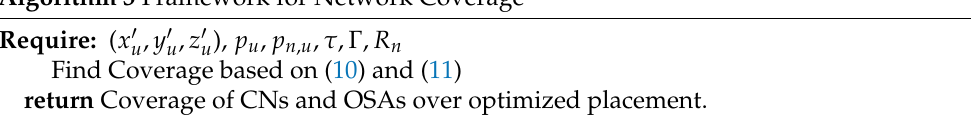
Algorithm 3 Framework for Network